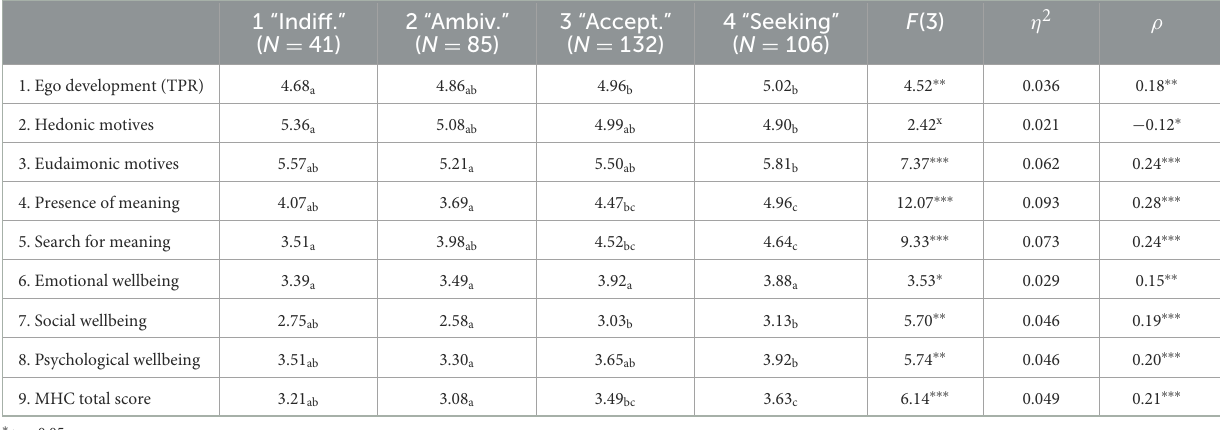
TABLE 5 Cluster means and one-way ANOVA results for the study